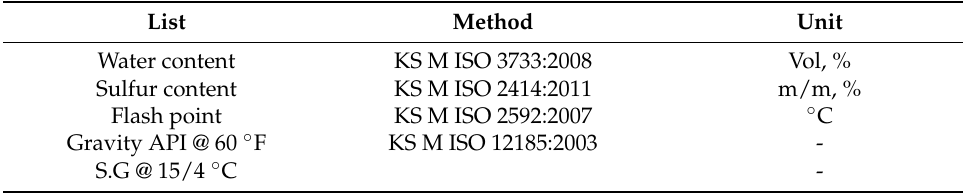
Table 1. ISO 8217 fuel component analysis methods.